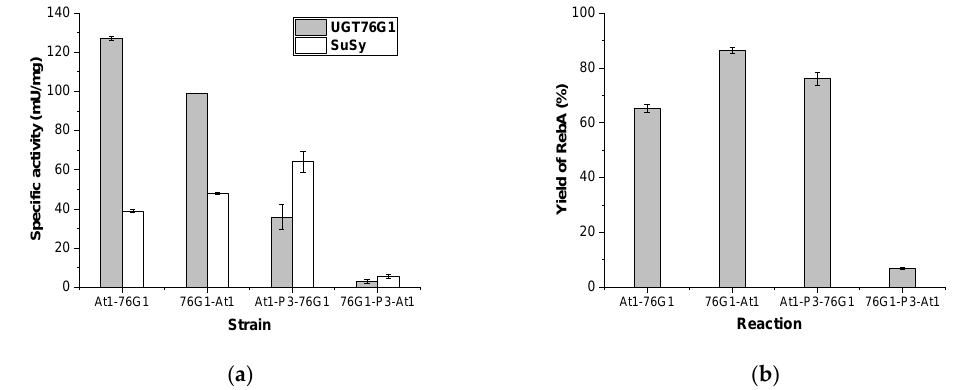
Figure 1. RebA production catalyzed by the free enzymes of UGT76G1 and At SUS1, and their fusion proteins. ( a ) The special activities of UGT and SuSy. ( b ) RebA yield of four reactions catalyzed by At1-76G1, 76G1-At1, At1-P3-76G1, and 76G1-P3-At1. The reaction mixture (20 mL), consisting of approximately 5 mg/mL of the crude extract, 20 g/L stevioside, and 60 g/L sucrose, was incubated at pH 7.2 and 30 °C for 5 h.